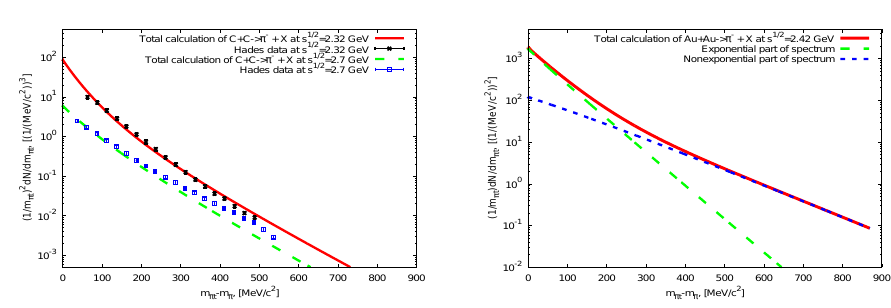
Figure 5. Left: results of our calculations of pion m π t -spectrum in C 12 C 12 collision in the mid-rapidity at the initial kinetic energy per nucleon about 1 GeV ( compared to the HADES data [32]. Right: our predictions of pion m π t -spectrum in AuAu collision in the mid-rapidity region or initial kinetic energy per nucleon about 1.25 GeV ( centrality about (0-5)%; the long dash line corresponds to the exponential part of pion spectrum given by Eq. (13) and the short dash curve corresponds to the non exponential part given by Eq.